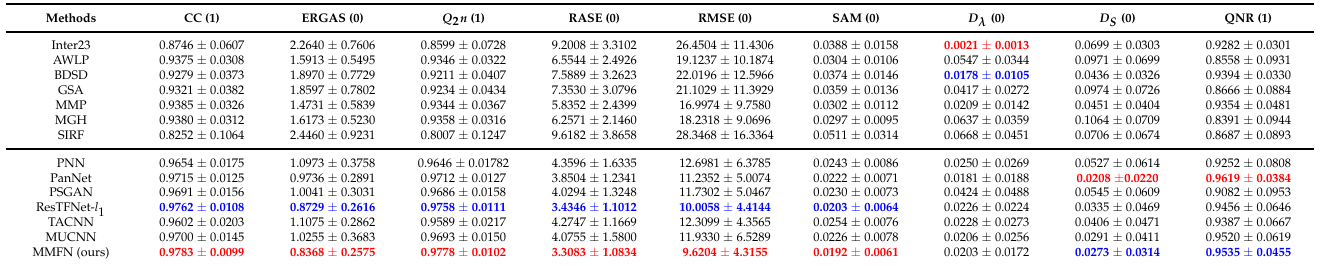
Table 2. Average quantitative performance on the QuickBird dataset. The best and second best performances are shown in Red and Blue , respectively.